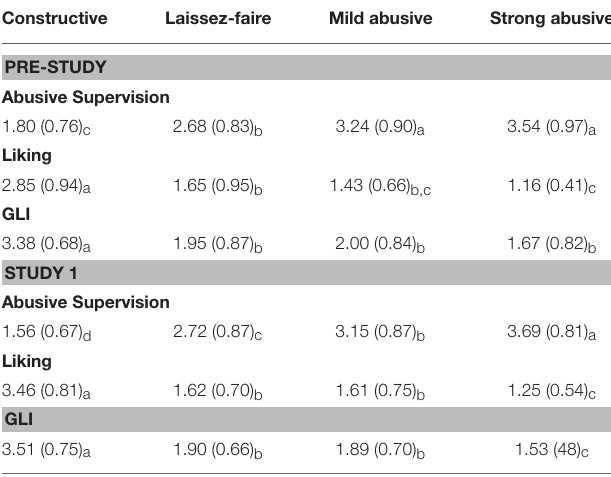
TABLE 1 | Mean values for abusive supervision, liking, and generalized leadership impression for the four vignettes